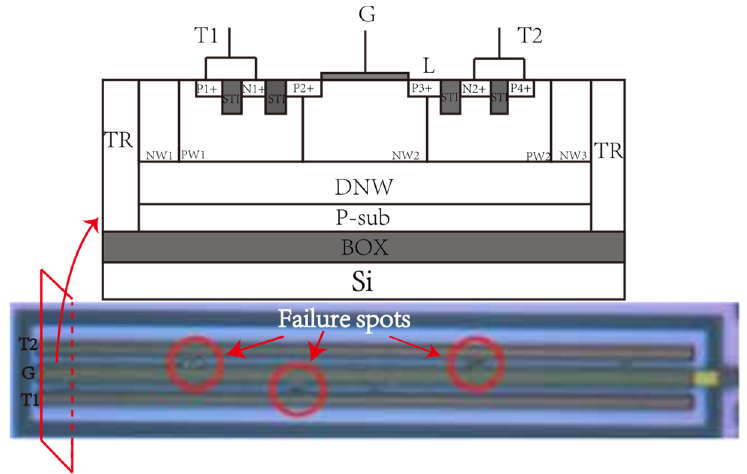
Figure 5. Failure spots induced by ESD stress of the PTBSCR (L = 0.5 μ m) in physical failure analysis.